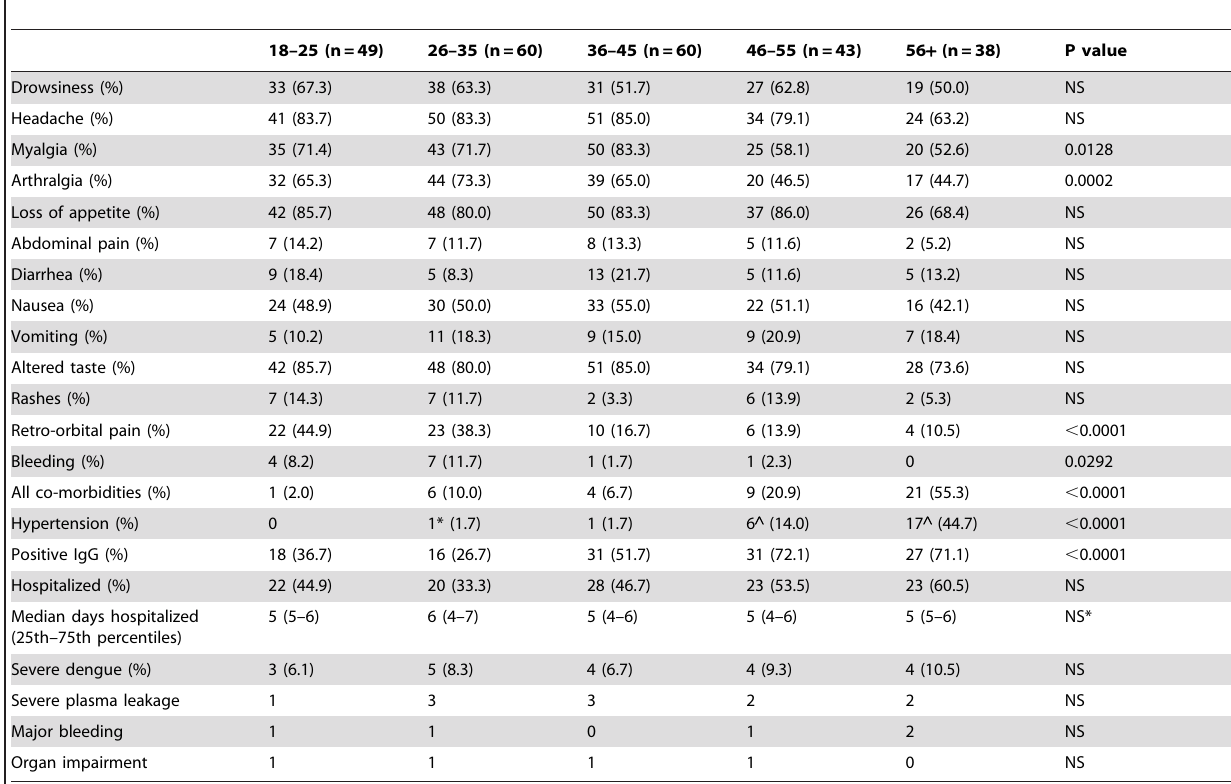
Table 7. The early age-specific features and clinical outcomes of dengue